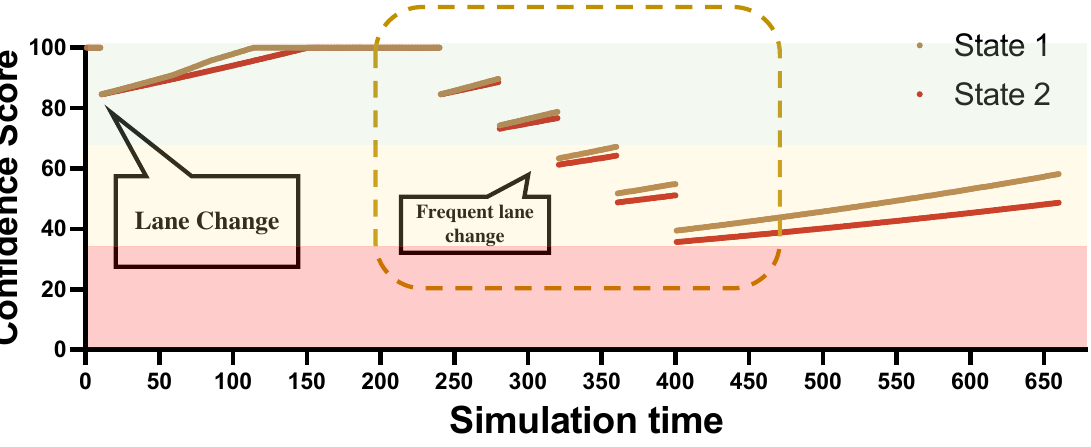
Figure 7. Real-time VC value in scenario two.